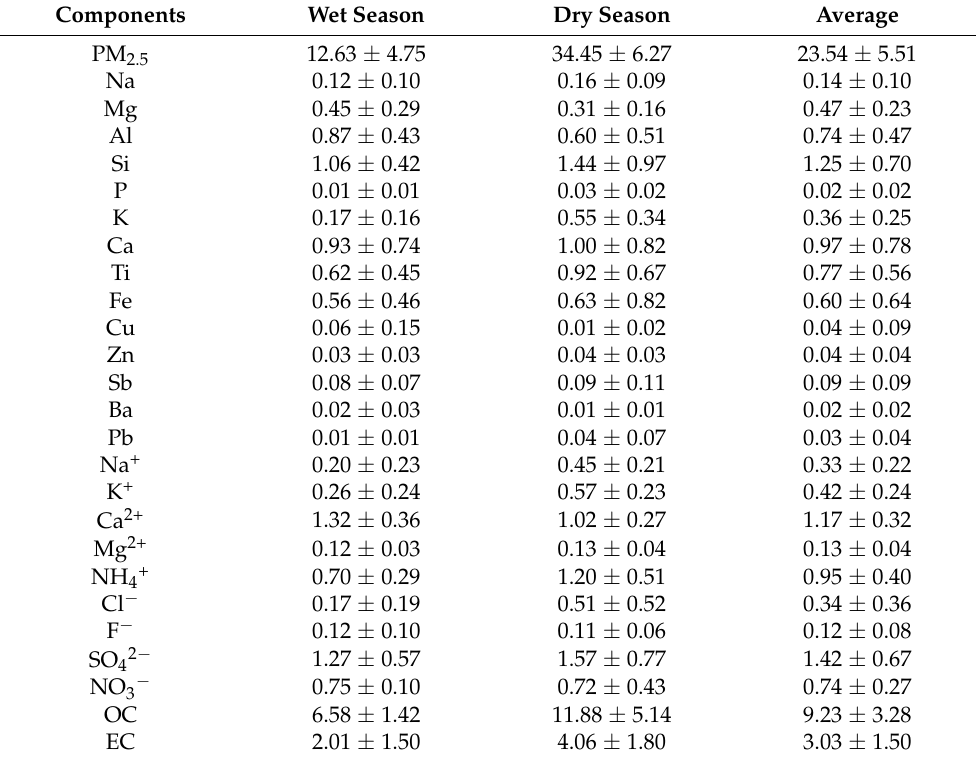
Figure 2. The daily mass concentrations of PM 2.5 during the sampling. Table 1. Concentrations of components in PM 2.5 ( µ g/m 3